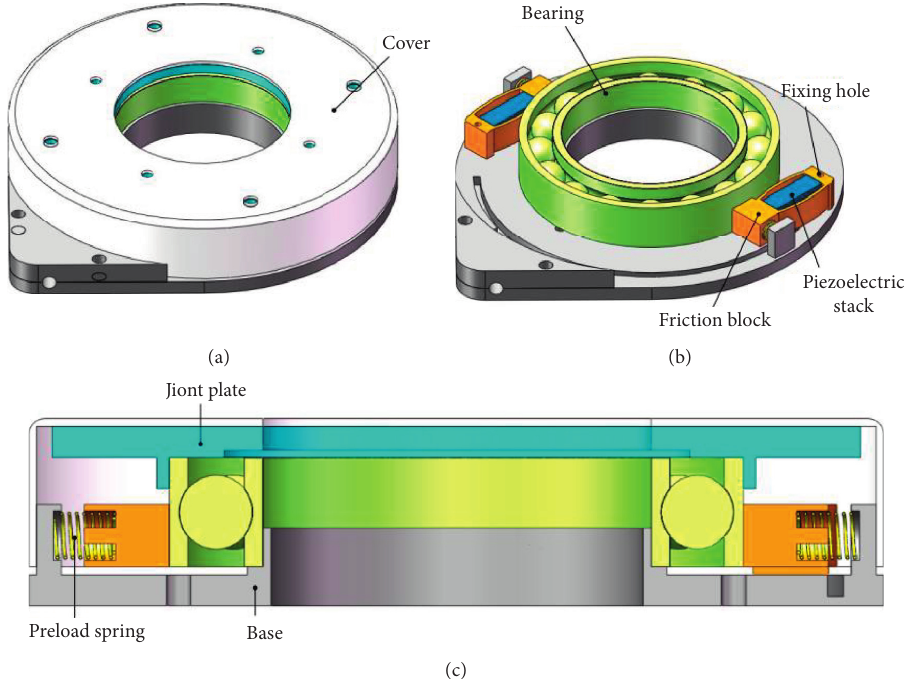
Figure 1: Configuration of the proposed piezoelectric rotary actuator. (a) 3D model. (b) Inside view. (c) A